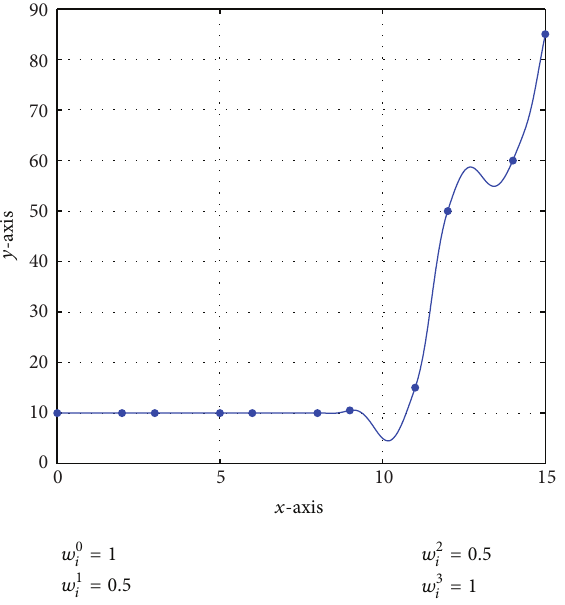
Figure 7: Nonmonotonicity preserving curve.